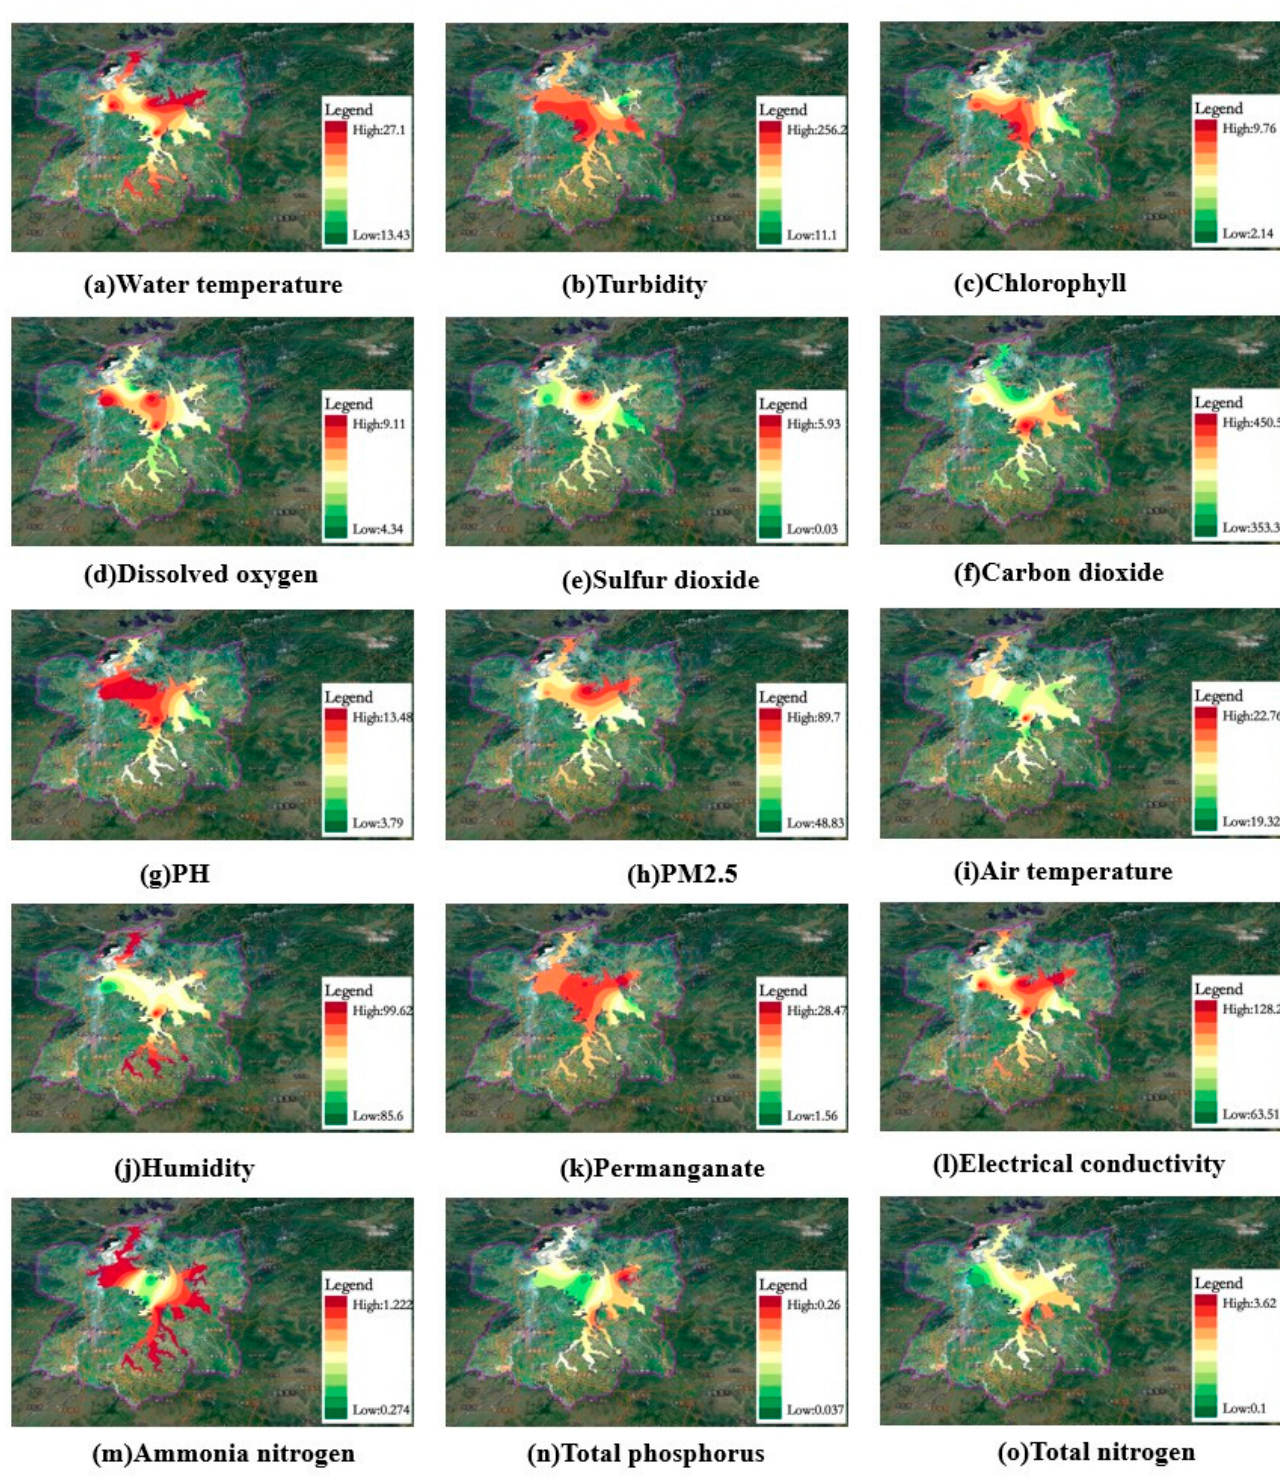
Figure 7. Visualization of the scalar fields of monitoring